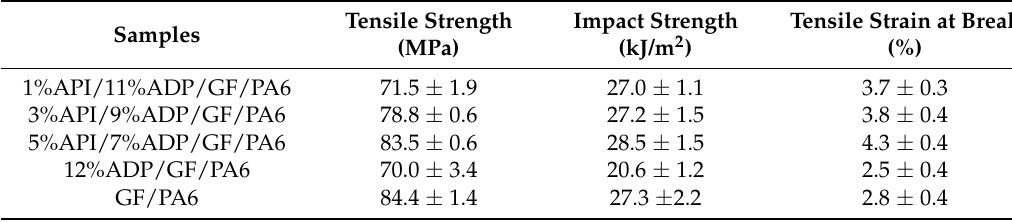
Table 5. Mechanical properties of PA6